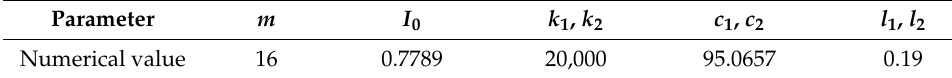
Table 1. Parameters of the vibration isolation system of the end